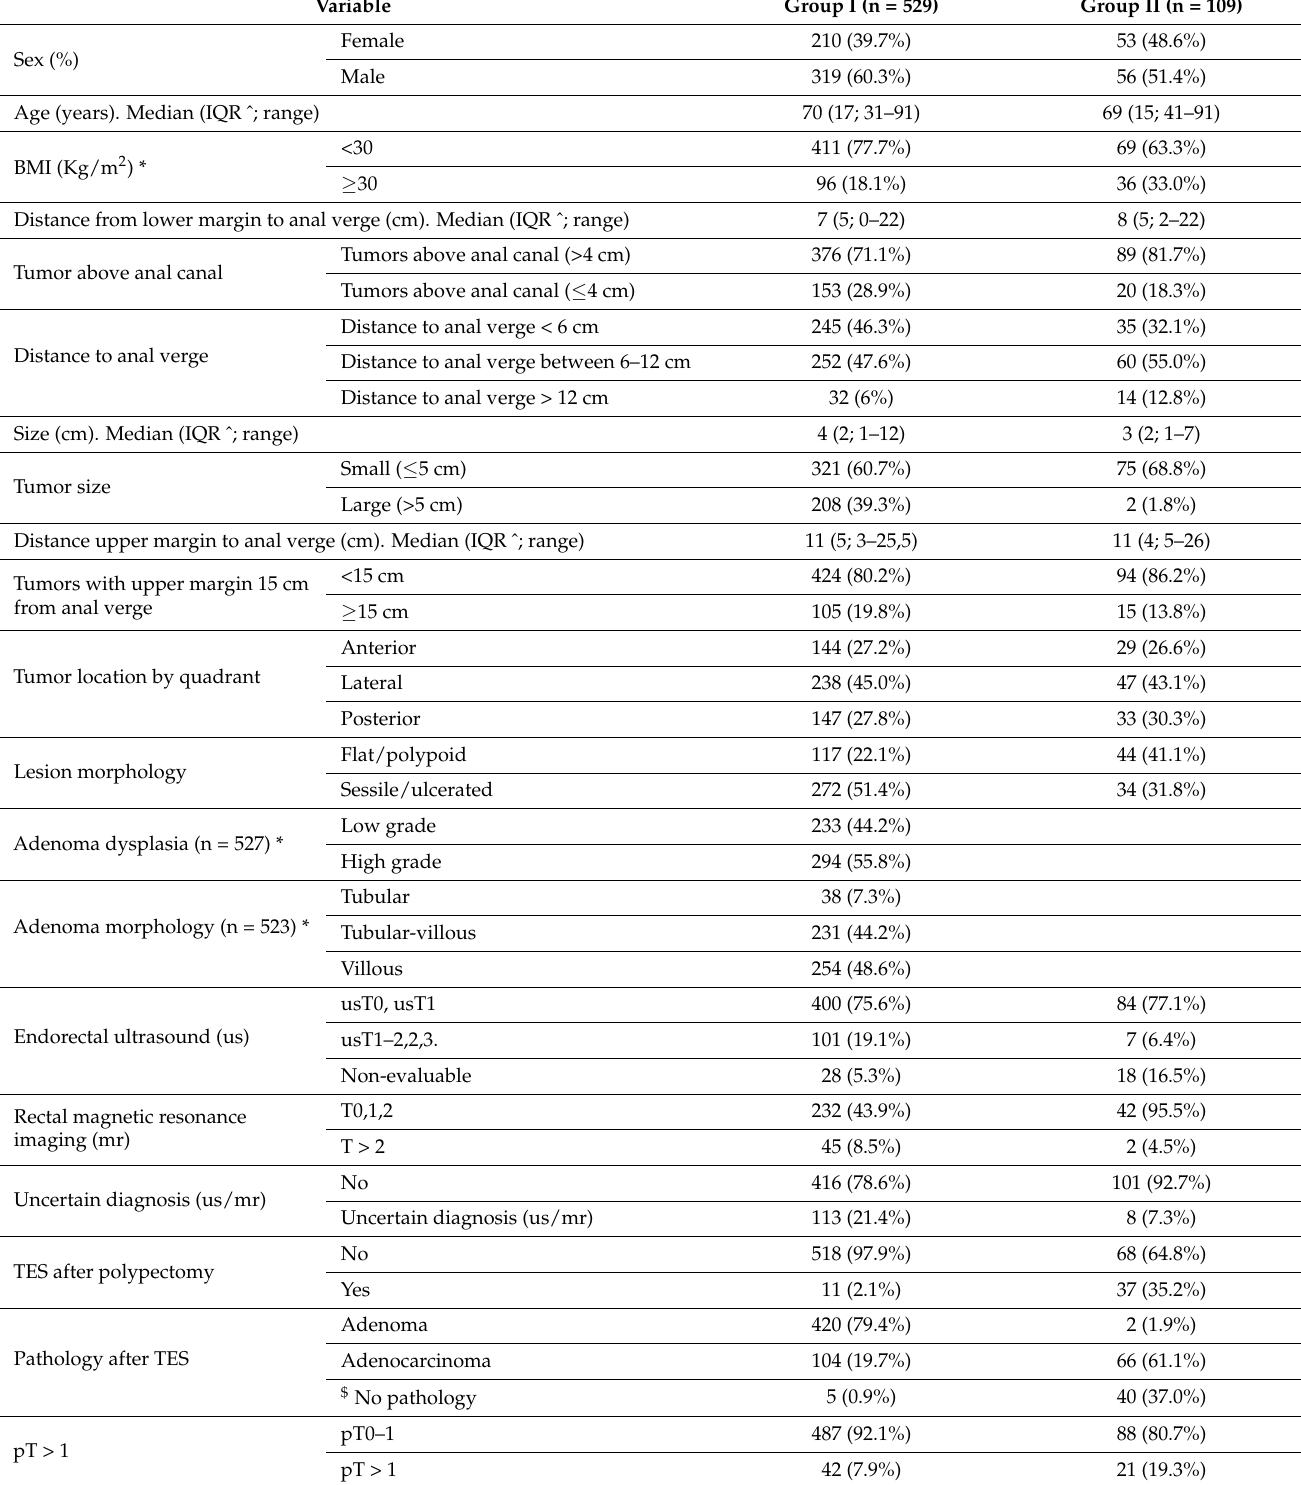
Table 1. Patients’ demographic characteristics and preoperative data of tumors in groups I and